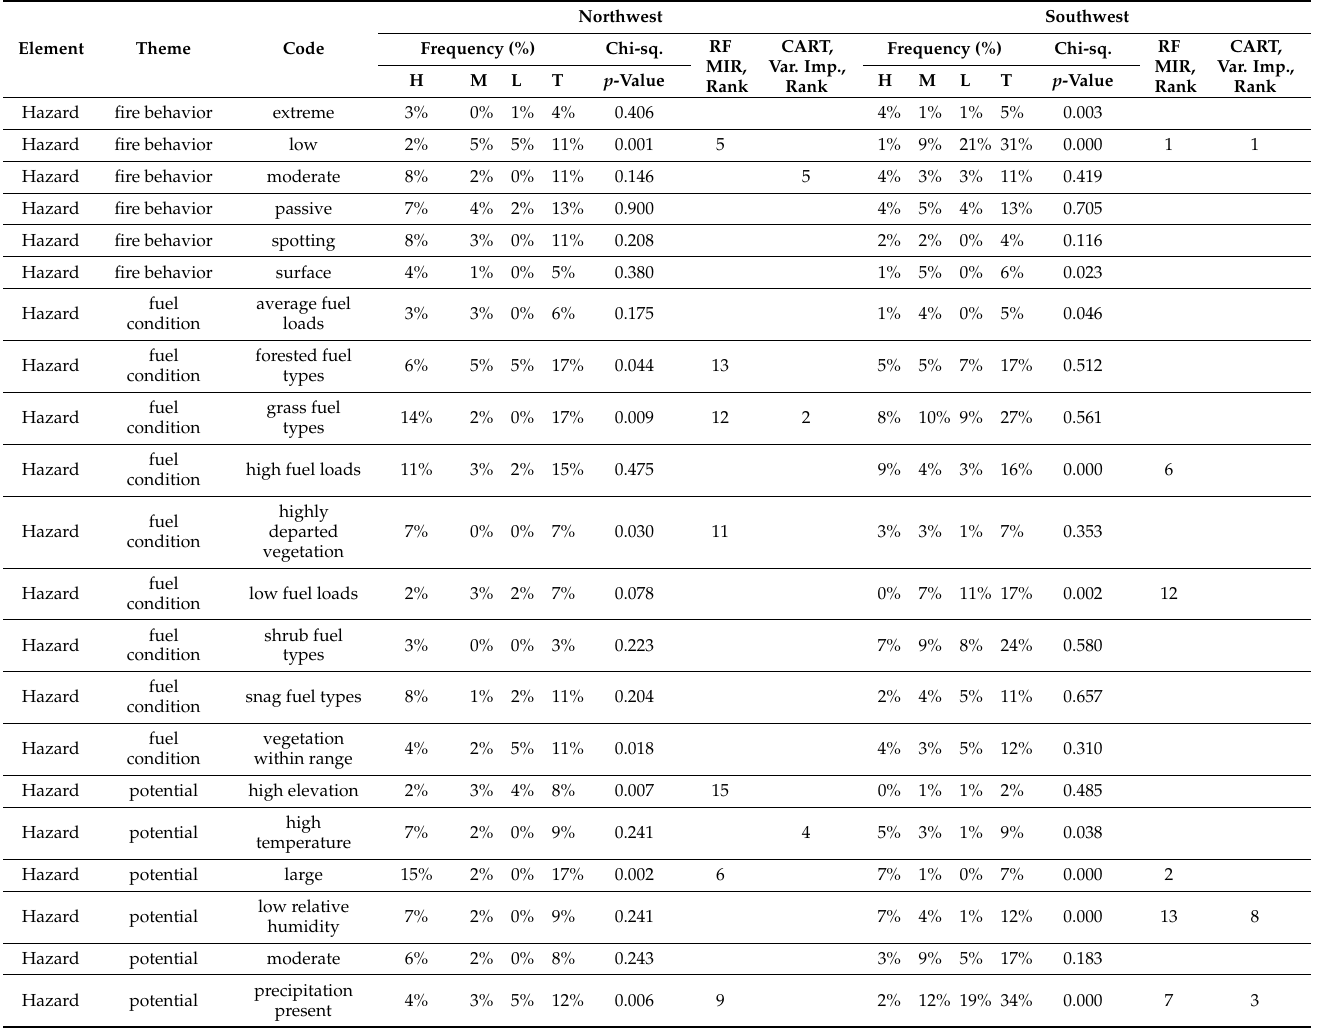
Table 2. Influential codes and associated themes and elements. Percent frequency of the occurrence of different codes (out of a total of 133 wildfires in the Northwest and 149 wildfires in the Southwest region) tallied by (H) High, (M) Moderate, (L) Low and (T) Total Relative Risk for each region. Chi-square p -values, (MIR) Model Improvement Ratio rankings from the Random Forest (RF) and the Variable Importance (Var. Imp.) ranking from the CART models are